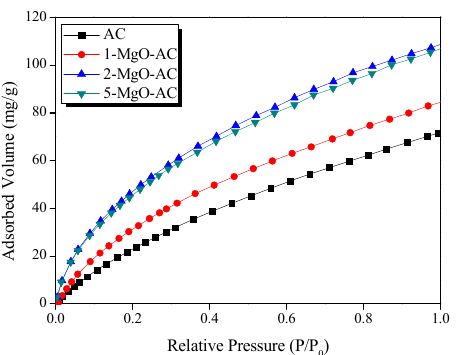
Figure 5. CO 2 adsorption capacity of the samples studied at 298 K and 1 atm.